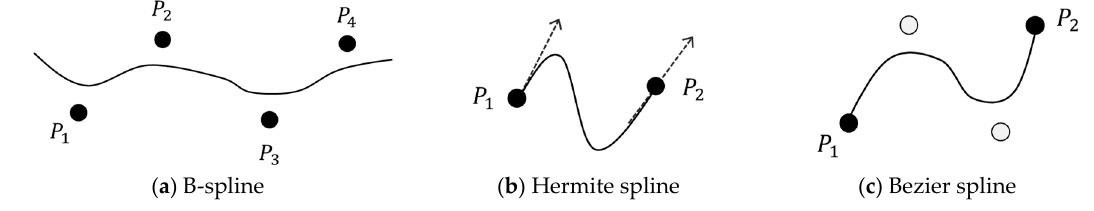
Figure 2. Concepts of B-, Hermite, and Bezier splines.